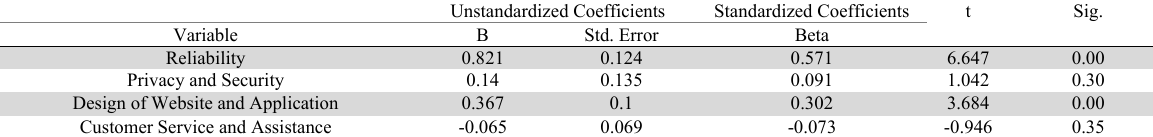
The results of regression analysis